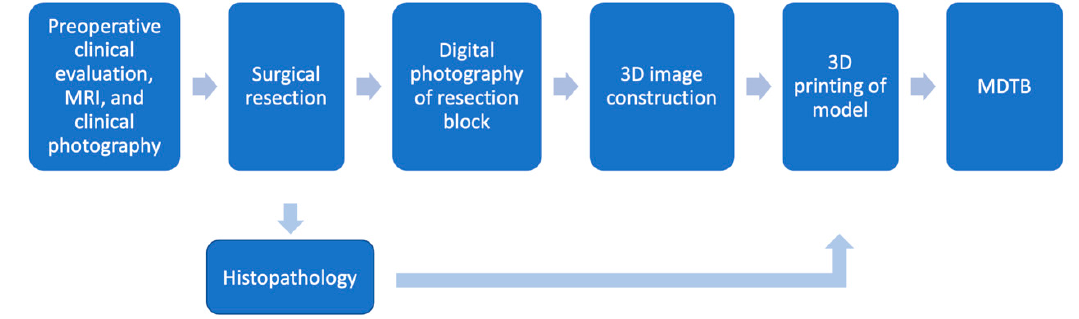
Figure 1. A diagram showing various steps of the project and their interaction (arrows), MDTB: multidisciplinary tumor board.